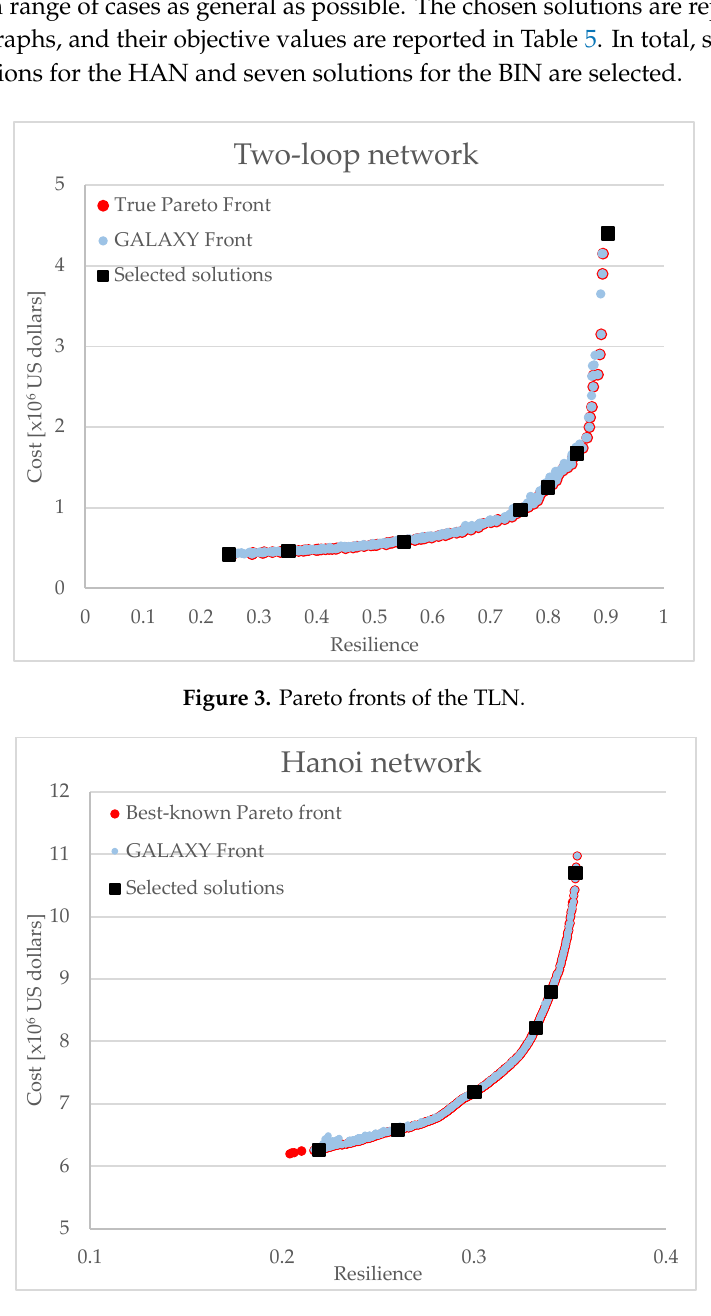
Table 5. In total, seven solutions for the TLN, six solutions for the HAN and seven solutions for the BIN are selected. Table 5. Solutions for each network.